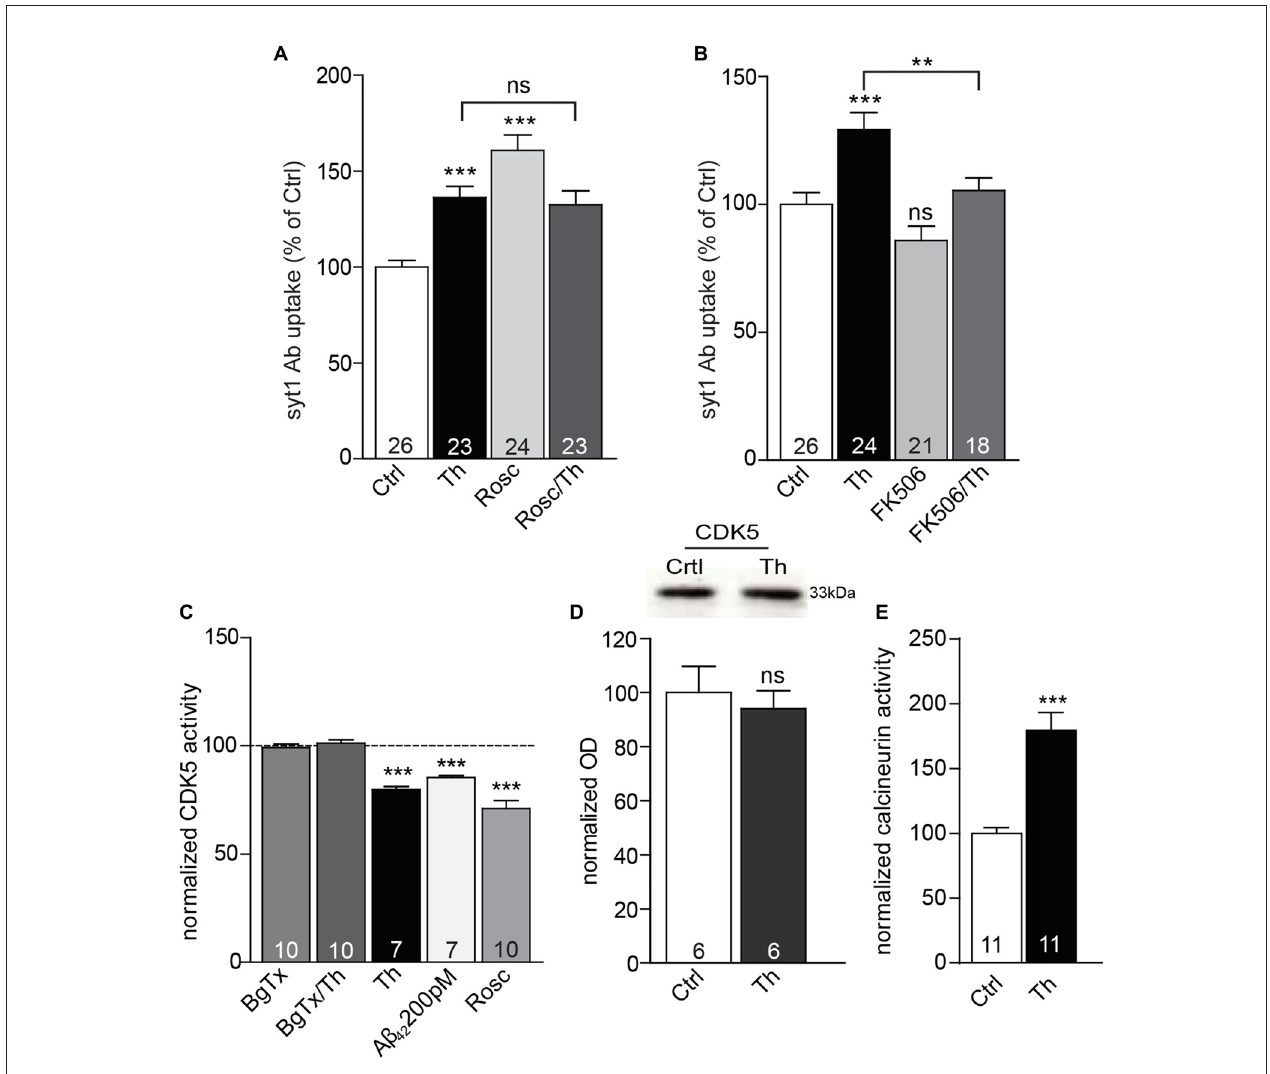
FIGURE 6 | CDK5 and calcineurin are involved in A β -driven presynaptic plasticity. (A) Quantification of depolarization-induced syt1 Ab uptake from cortical neuronal cultures treated with control, Th and/or roscovitine (Rosc) to evaluate the impact of CDK5. (B) Statistical analysis of depolarization-induced syt1 Ab uptake from cortical cells incubated with vehicle, Th and/or FK506 to investigate the relevance of calcineurin signaling. Numbers within columns in (A,B) represent the number of analyzed cells obtained from three independent cell culture preparations. (C) CDK5 activity assay performed from cortical cultures under different conditions. (D) Representative Western blot as well as quantification of the total CDK5 protein levels from vehicle- or Th-treated cultures. Molecular weight is indicated in kDa. The numbers represent the number of samples from two independent primary culture preparations. (E) Calcineurin activity assay conducted from cortical cells incubated with vehicle or Th. Numbers within columns in (C,E) denote the number of independently treated and analyzed wells in a multi-well dishes obtained from three (C) or four (E) different cell culture preparations. In all graphs, values are expressed as the mean ± SEM. Statistical significance was assessed by one-way ANOVA with Bonferroni post hoc test (A–C) or Student (D) and Mann Whitney t test (E) ; ∗∗ p < 0.01, ∗∗∗ p <